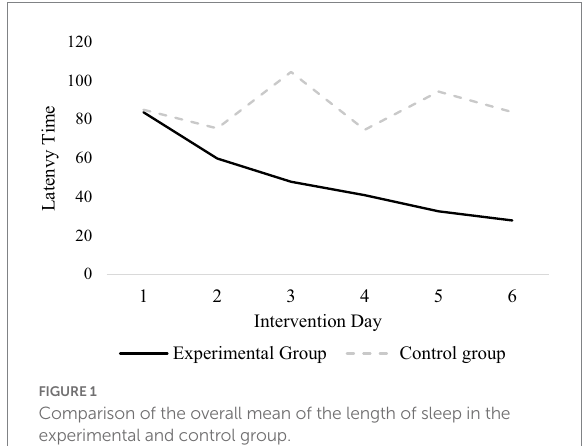
FIGURE 1 Comparison of the overall mean of the length of sleep in the experimental and control group.